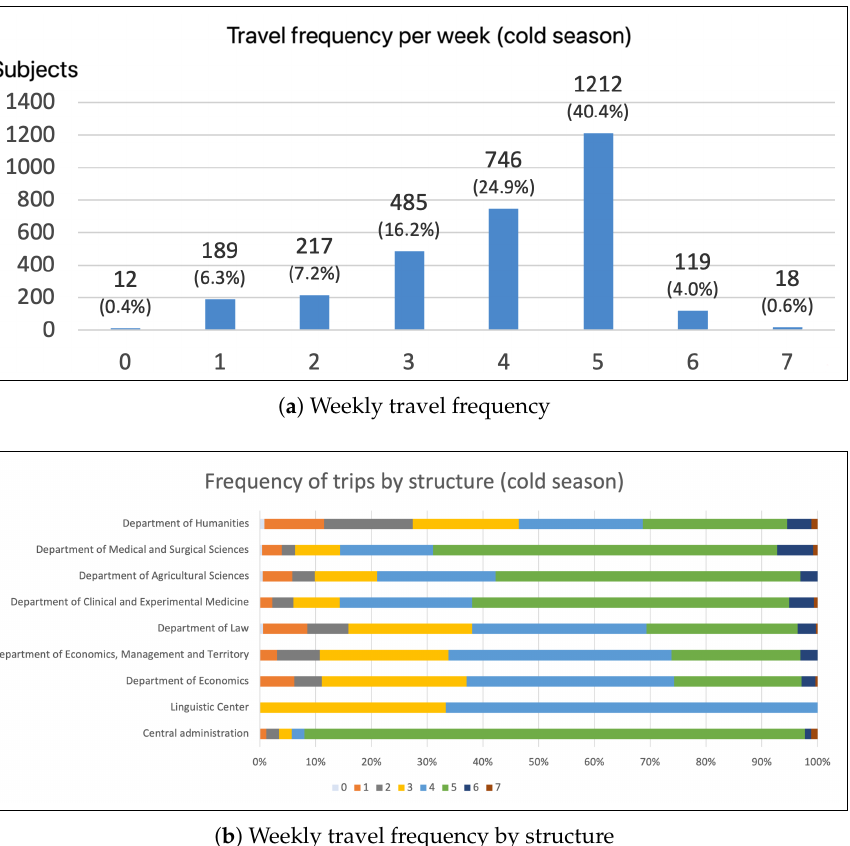
Figure 13. Travel in cold